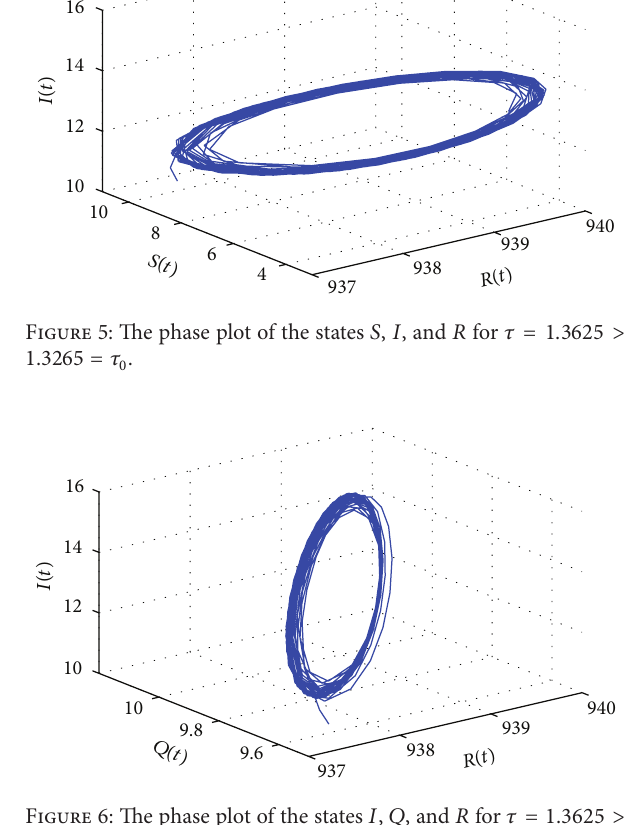
Figure 6: The phase plot of the states 𝐼 , 𝑄 , and 𝑅 for 𝜏 = 1.3625 > 1.3265 = 𝜏 0